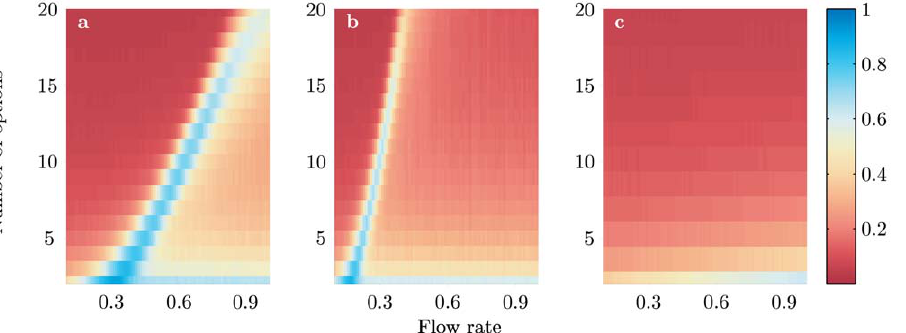
Figure 3. Decision quality as a function of the flow rate of individuals w and of the number of options n as obtained by Monte Carlo simulations. (a) case m ~ 2 , (b) m ~ 3 and (c) m ~ 1 . Other parameter values as in Fig. 1, number of realizations is 5000.